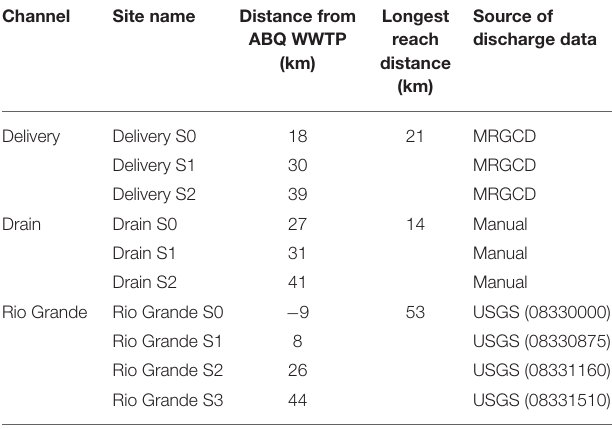
TABLE 1 | Sampling sites and their distance from the Albuquerque WWTP.